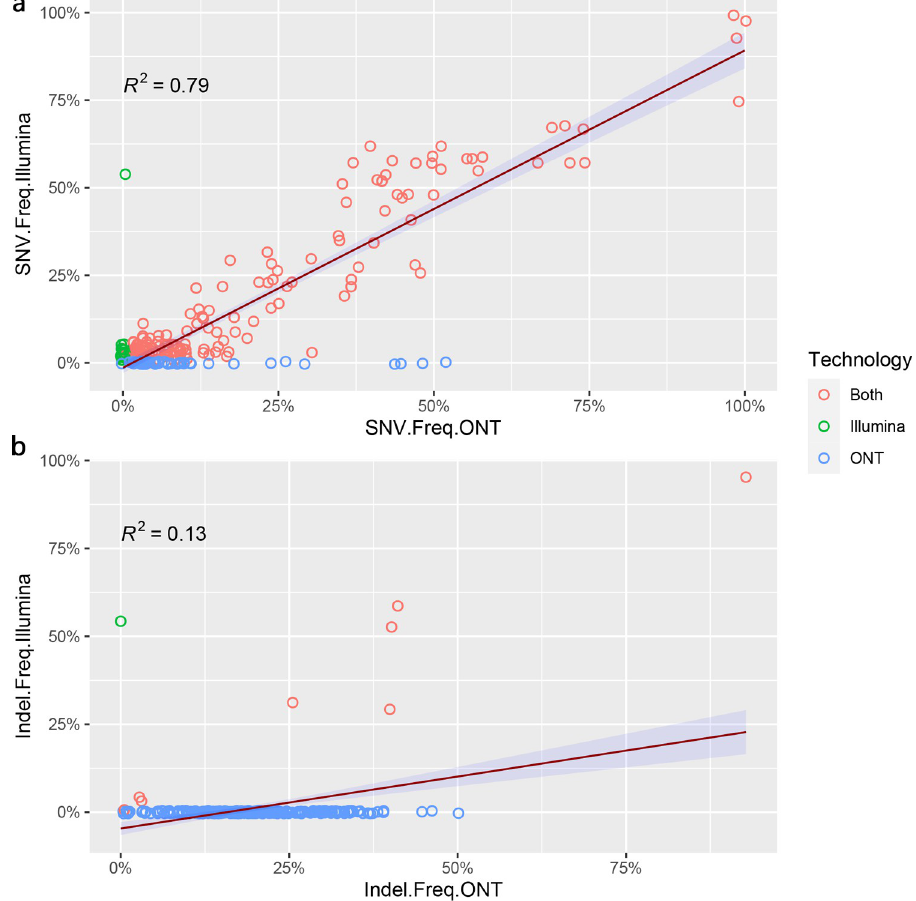
Fig 5. Correlation of sub-consensus allele frequencies observed for SNV and Indels between two sequencing technologies. a) Correlation between sub-consensus single nucleotide substitution frequencies observed for Illumina and ONT. Nucleotide substitutions detected exclusively by one technology are indicated in green and blue whereas the substitutions detected by both technologies are colored red. Even though more nucleotide substitutions exclusive to ONT were observed, there is a clear positive correlation (R 2 = 0.79) between two sequencing technologies. b) Correlation between sub-consensus indel frequencies observed for Illumina and ONT. More indels exclusive to ONT can be seen with a weak correlation (R 2 = 0.13) between the indel frequencies between two technologies suggesting ONT tend to result in more false-positive